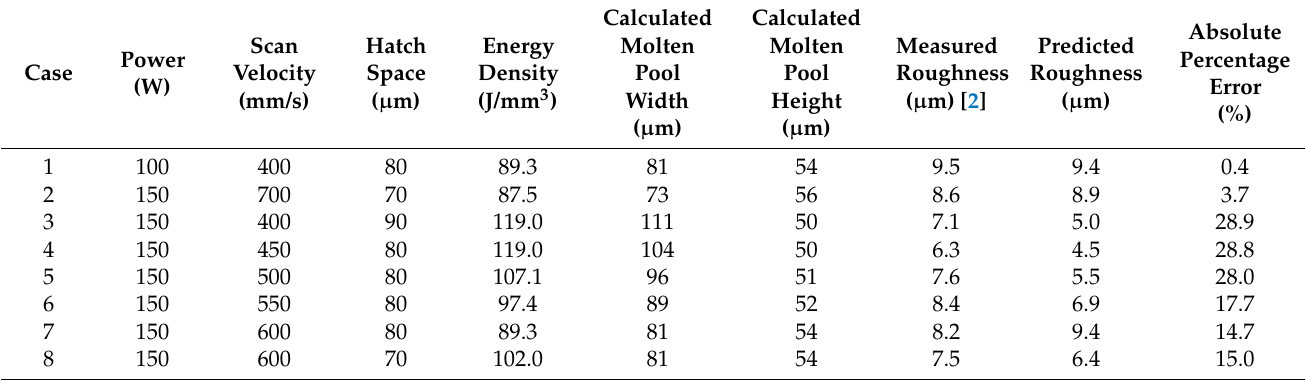
Table 2. Validation of predicted results against experimental data. The layer thickness is 35 µ